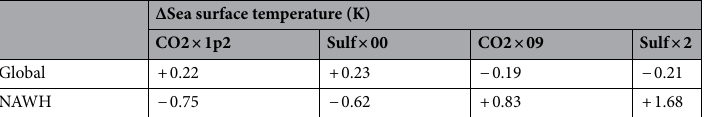
Table 1. Anomalies of the annual mean sea surface temperature averaged over global and the NAWH region for each sensitivity experiments from the base experiment.